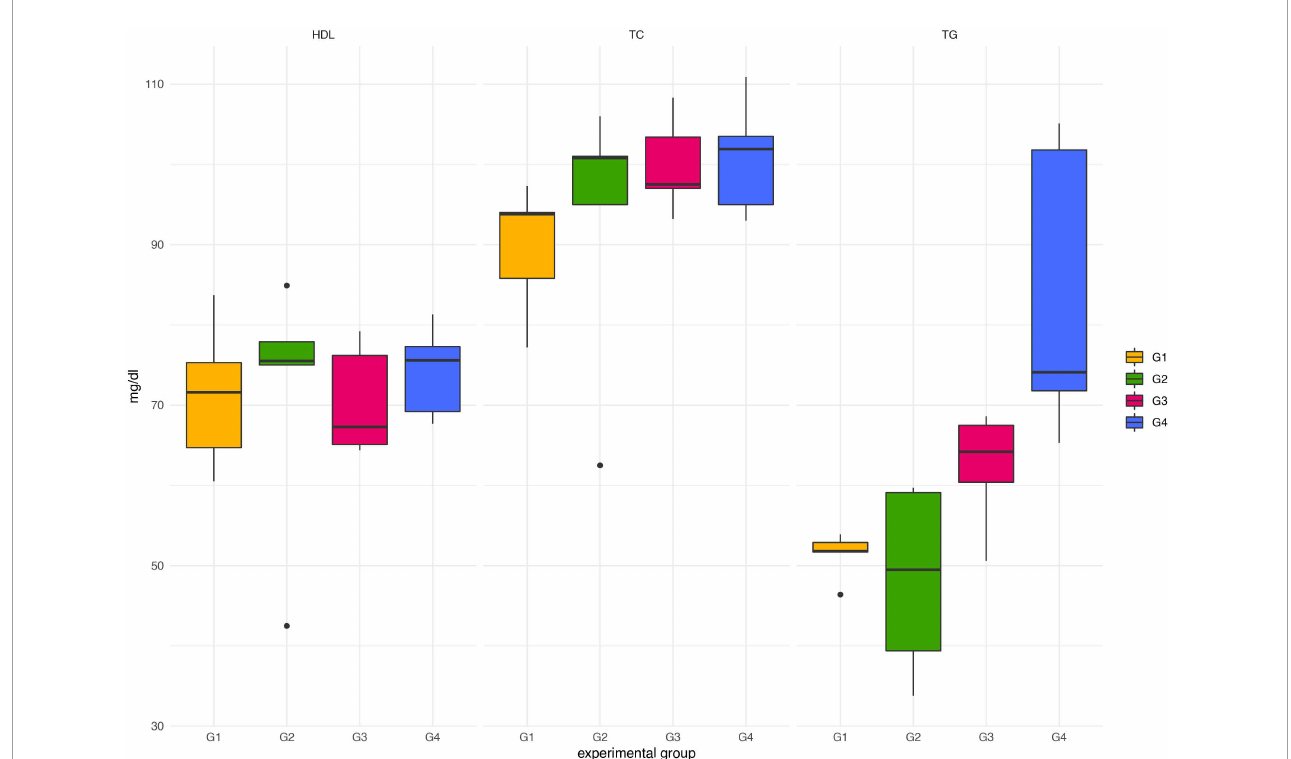
FIGURE2 Lipid profile in mice of G1, G2, G3, and G4 at the end of the experimental period (day 38). TC, total cholesterol; HDL-C, high-density lipoprotein cholesterol; TG, triglycerides.